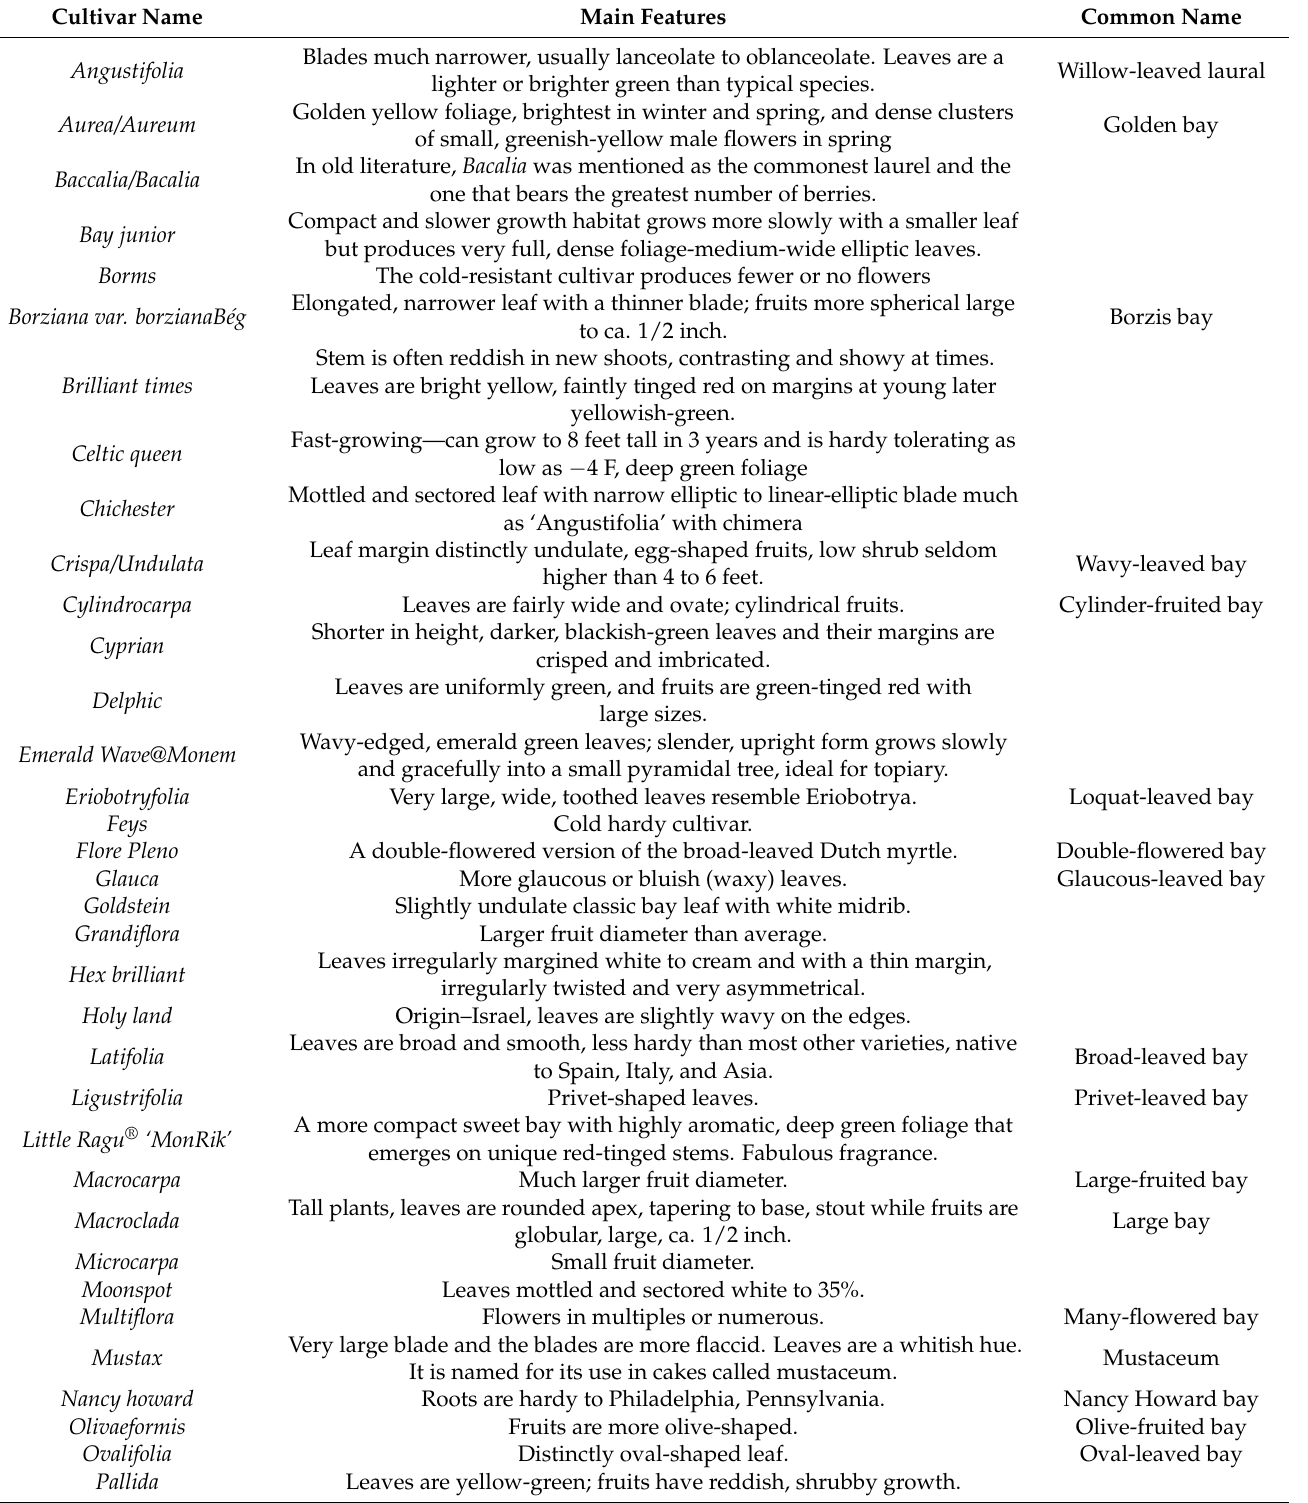
Table 1. Salient features of selected bay